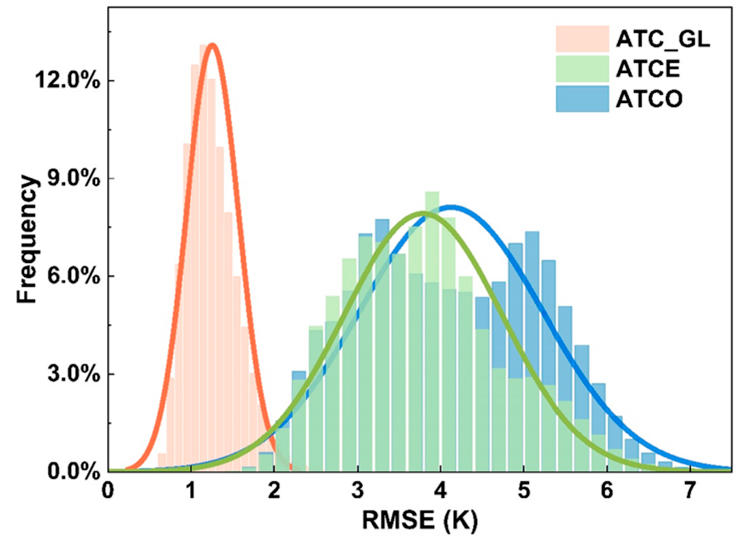
Figure 5. The RMSEs estimated for the ATC_GL, ATCE, and ATCO for Regions A–G (see Figure 1). The ATC_GL had the highest accuracy for all land cover types (Figure 6). The highest and lowest RMSE for the ATC_GL was estimated in barren land (1.81 K) and farmland (0.92 K), respectively. The RMSEs of the ATCE and ATCO were relatively similar (Figure 6); both the ATCE and ATCO showed maximum RMSEs in barren land (5.29 K and 5.53 K, respectively) and minimum RMSEs over water bodies (2.81 K and 3.04 K, respectively). The pronounced differences in RMSE between the land cover types for the ATCE and ATCO (more than 2.0 K) indicate that the performance of the ATC_GL remained relatively stable. The accuracy enhancement of the ATC_GL was the highest in barren areas (exceeding 3.5 K), with lower differences in accuracy observed between the models for forests, wetlands, and water bodies (more than 1.5 K; Figure 6). This result may reflect the reduced degree of LST fluctuation over dense vegetation and areas with high soil moisture because of higher levels of evapotranspiration and specific heat capacity [52–55].